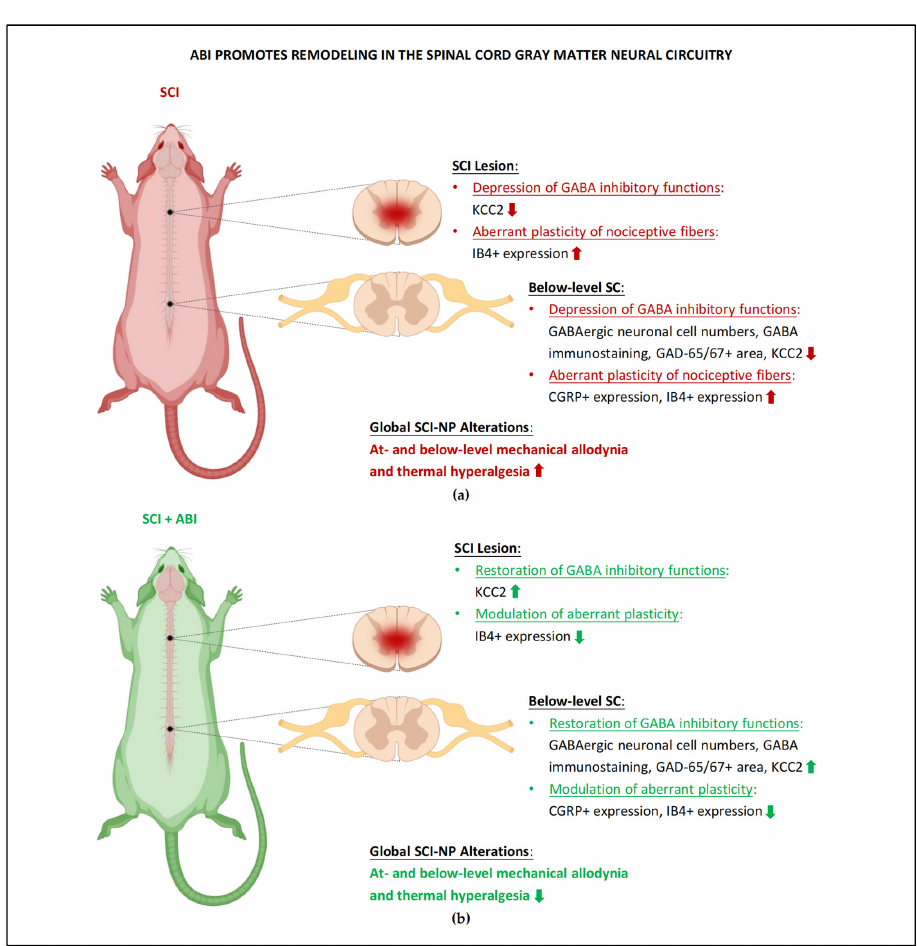
Figure 2. ABI promotes remodeling in the spinal cord gray matter circuitry. ( a ) Overview of the maladaptive plasticity in the spinal cord neural circuitry of SCI-NP rodents. GABA inhibition was depressed throughout the lesion site and below-level spinal cords during numerous pain states, and aberrant plasticity of C-/A δ -fibers was observed in below-level segments, which were associated with the development of mechanical and thermal hypersensitivity. ( b ) Restoration of GABA inhibitory functions and modulation of aberrant plasticity was detected in the spinal cord gray matter neural circuitry of SCI+ABI animals. Reduced CGRP- and IB4-labeling density/expression in the dorsal horn of the lumbar spinal cord demonstrates that aberrant plasticity of nociceptive fibers after SCI can be modulated by ABI of the spinal cord neural circuitry below the lesion, leading to reduced mechanical and thermal hypersensitivity. The abbreviations that appeared above were explained in the main text. The figure was created with BioRender.com.